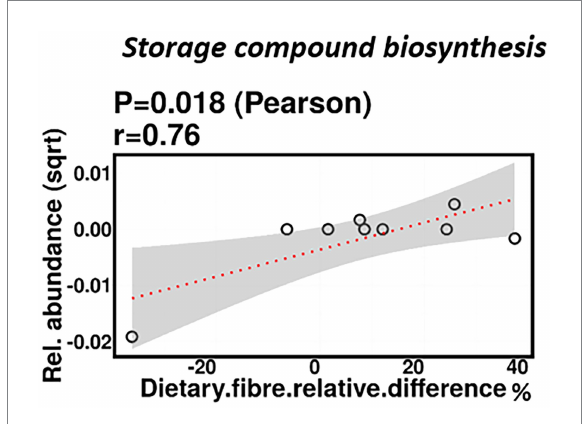
FIGURE 7 Change in maternal fiber intake % was positively correlated with the abundance of genes involved in storage compound